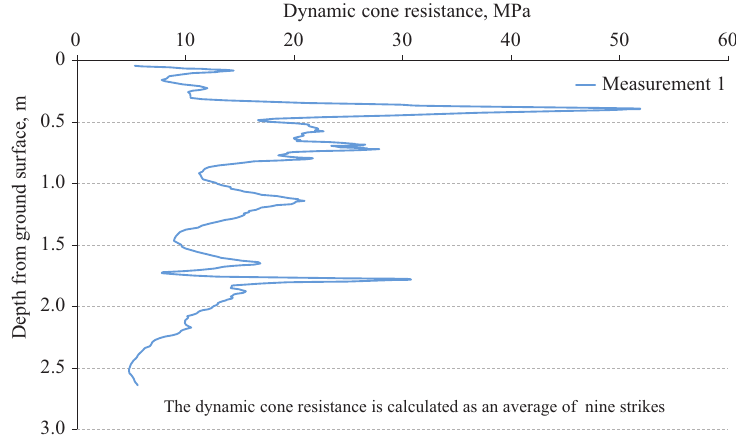
Figure 12. Test results for the km44